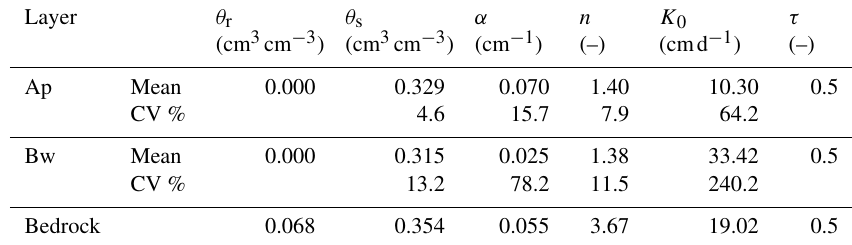
Table 1. Statistics (mean and coefficient of variation, CV) of the hydraulic property parameters of the two soil layers and bedrock.